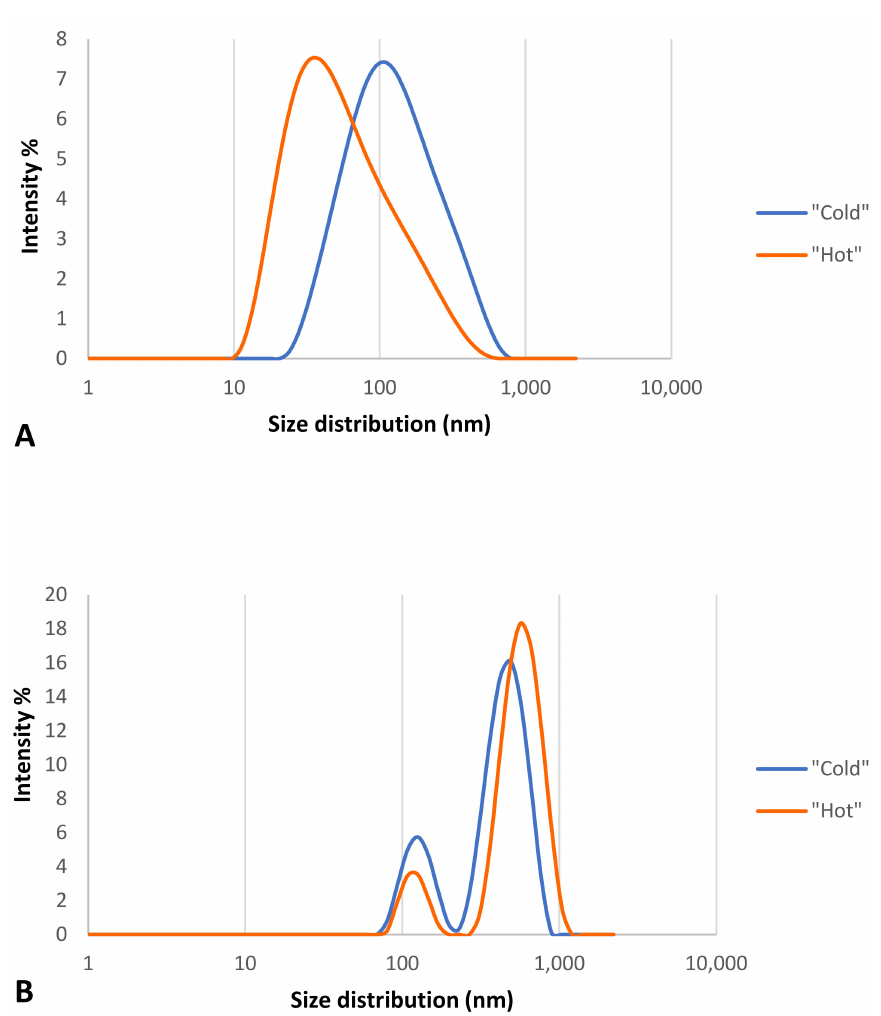
Figure 7. Size distribution analysis graph for “cold” and “hot” AuNPs by intensity. ( A ) before corona formation and ( B ) after corona